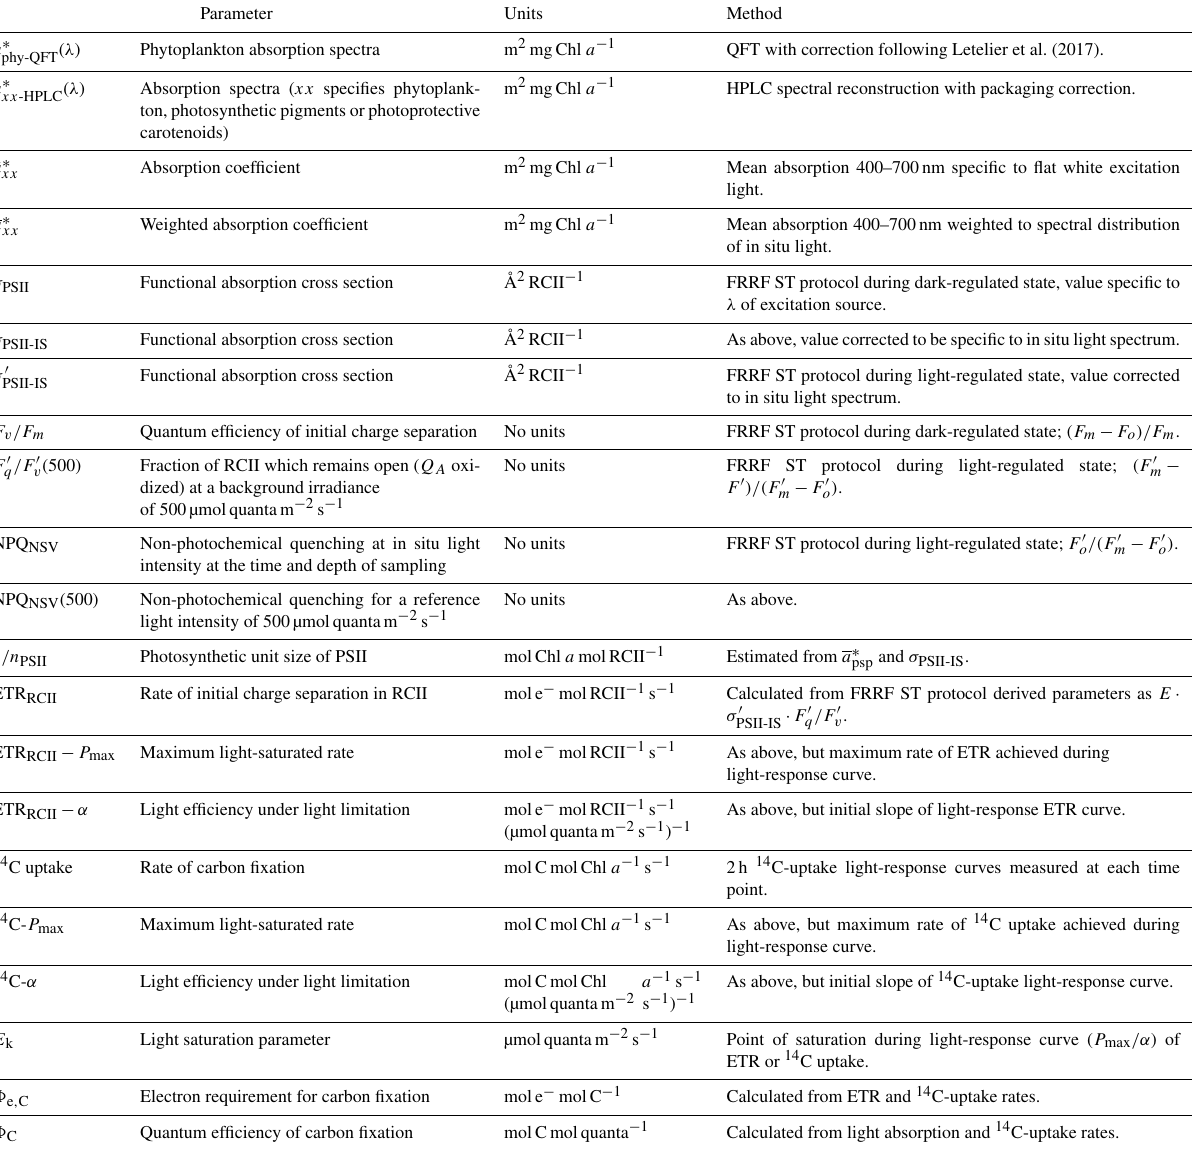
Table 1. List of parameters derived and discussed in the